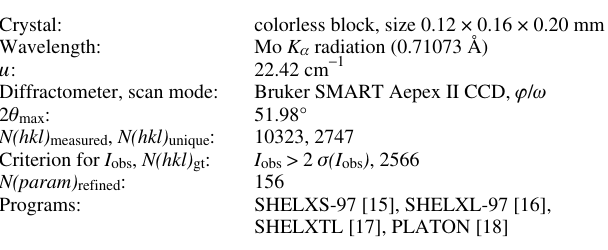
Table 1. Data collection and